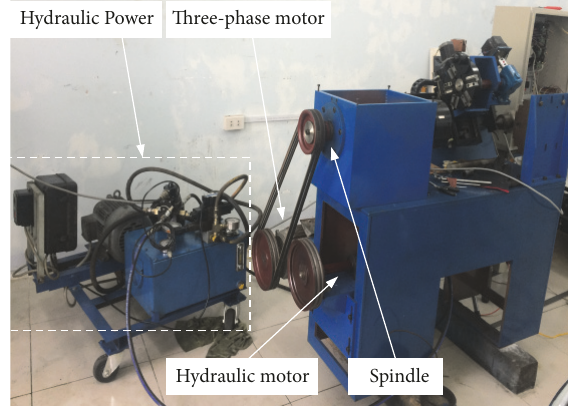
Figure 20: Picture of experimental equipment.